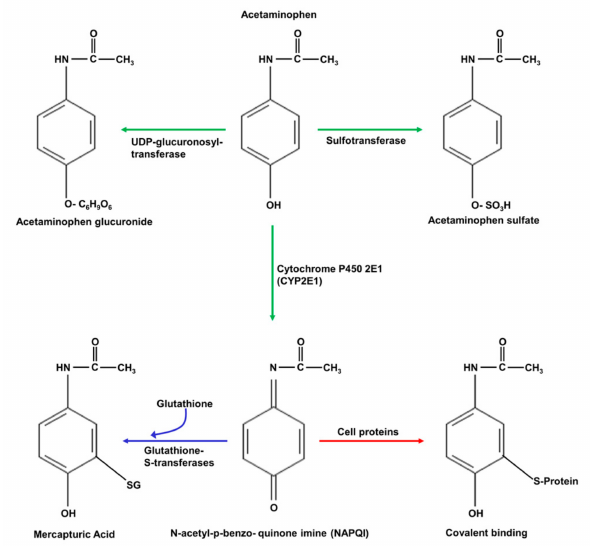
Figure 4. The pathways by which acetaminophen is metabolised in hepatocytes. Acetaminophen is initially metabolised by UDP-glucuronosyl transferase, sulfotransferase, and cytochrome P450 2E1 (green arrows). The resulting acetaminophen glucuronide and acetaminophen sulphate are excreted from hepatocytes via the bile canaliculus. In a reaction with glutathione (GSH), the product of cytochrome P450 2E1, N-acetyl-p-benzoquinone imine (NAPQI), is converted to mercapturic acid (blue arrow), which is also excreted in bile fluid. Acetaminophen can also be N-deacylated to form p-amino-phenol sulphate (not shown). At high doses of acetaminophen, such as in acetaminophen toxicity, the glutathione available for the conversion of NAPQI to mercapturic acid is exhausted. Consequently, NAPQI accumulates and reacts with, and inactivates, enzymes and other proteins in the liver (red arrow). Moreover, the deficiency in glutathione caused by high levels of NAPQI reduces the ability of hepatocytes to remove the ROS generated in other reactions, leading to further ROS-induced damage to proteins